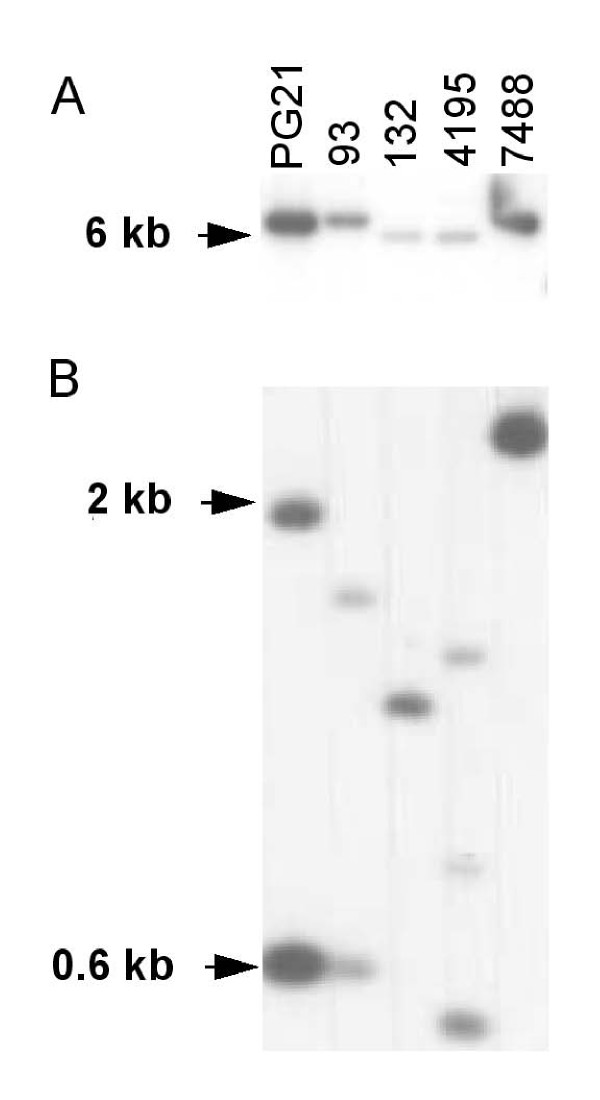
Restriction endonuclease analysis (REA) of the vaa locus. Southern blottings of HindIII cleaved genomic DNA of the 5 isolates separated by agarose gel electrophoresis and probed with sequences specific for the 5' end (probe 2, frame A) and 3' end (probe 4, frame B) of vaa, respectively.